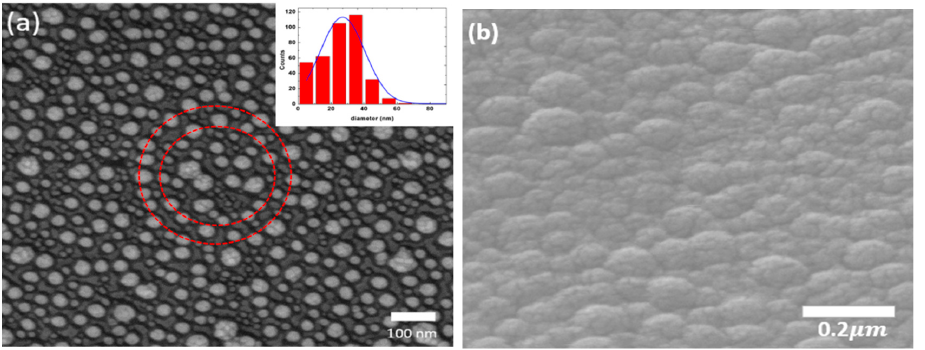
Figure 1. SEM images of the ( a ) Ag nanoparticles with the average size of 28 nm. The inset shows the distribution of particle sizes. ( b ) the Ag nanoparticles covering the TiO 2 film film.